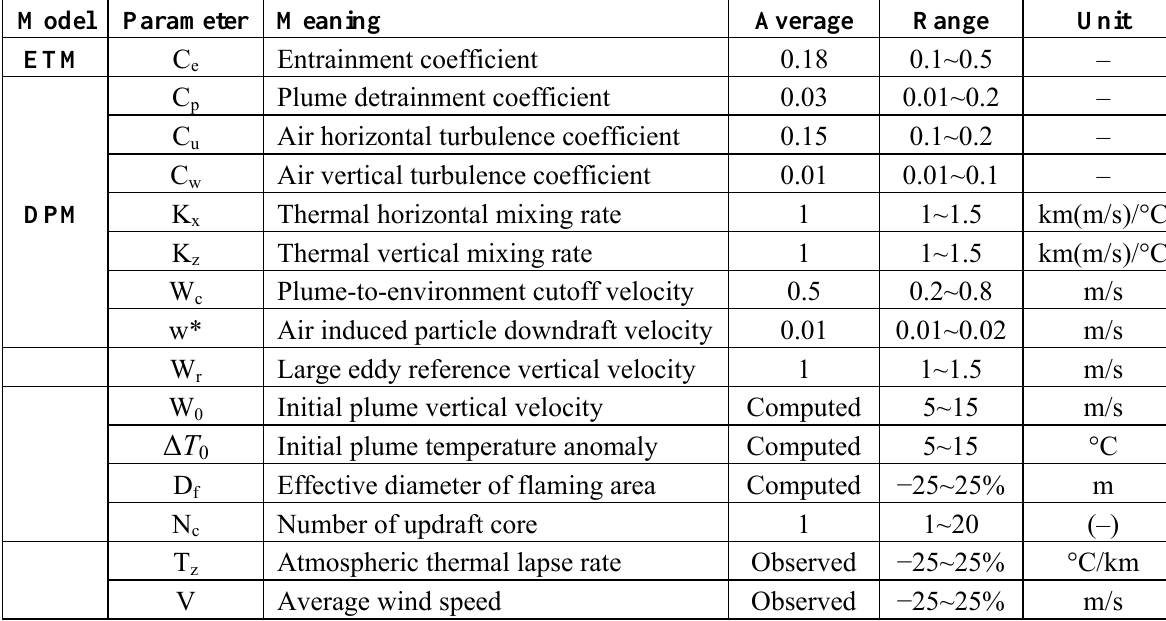
Table 2. Parameters used in the FAST sensitivity analysis for Daysmoke. The ranges shown for D , T , and V are relative f z